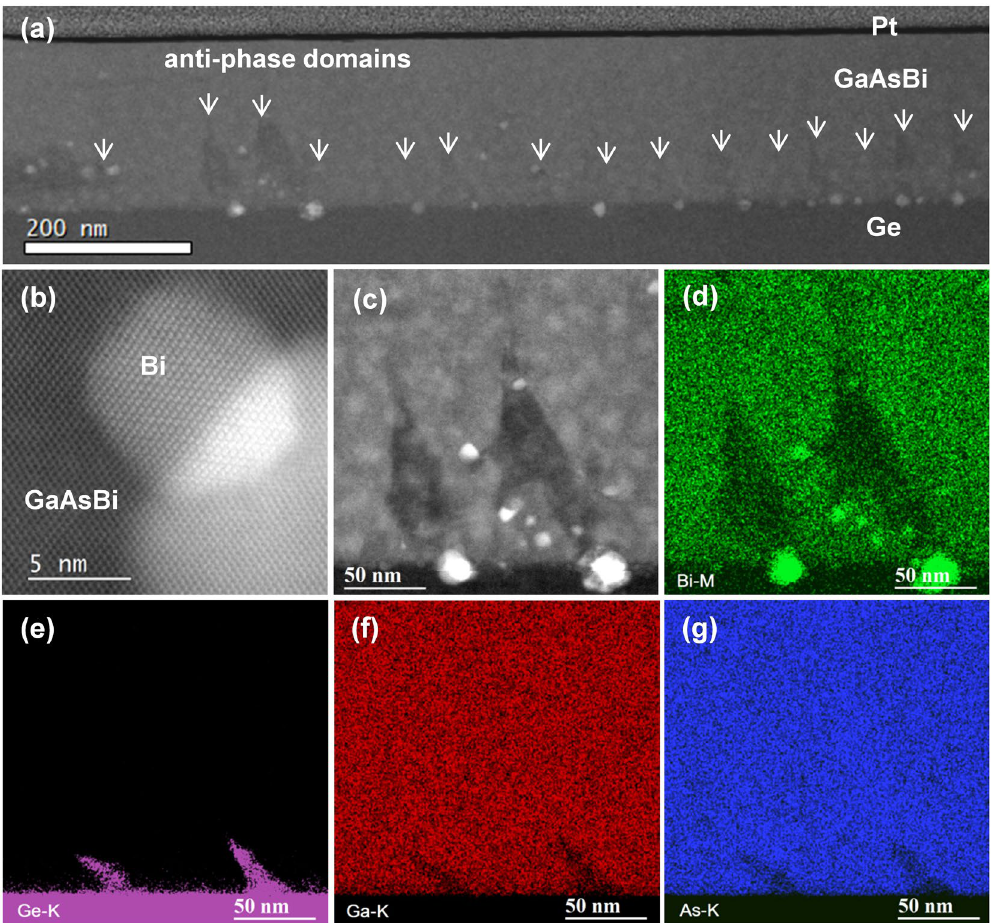
Figure 4. ( a ) HAADF image of sample S1 annealed at 600 °C. Anti-phase domains are indicated with arrows. ( b ) HAADF image of a rhombohedral Bi droplet formed within the bismide film. ( c – g ) Simultaneously